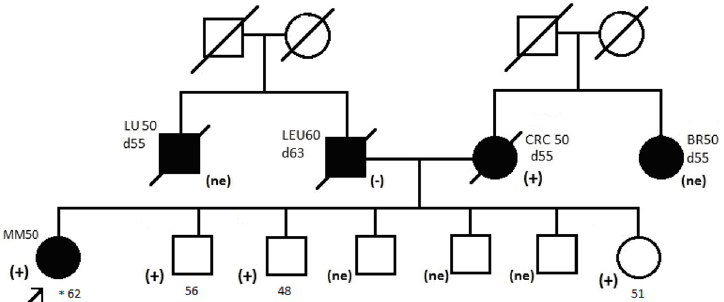
Fig 2. Pedigree of the family with c.4534 C > T detected variant. (cid:3) age. Abbreviation: Leu, leukemia; Br, breast cancer; Lu, lung cancer; CRC, colorectal cancer; (+), mutation positive; (-), mutation negative; (ne), not examined.